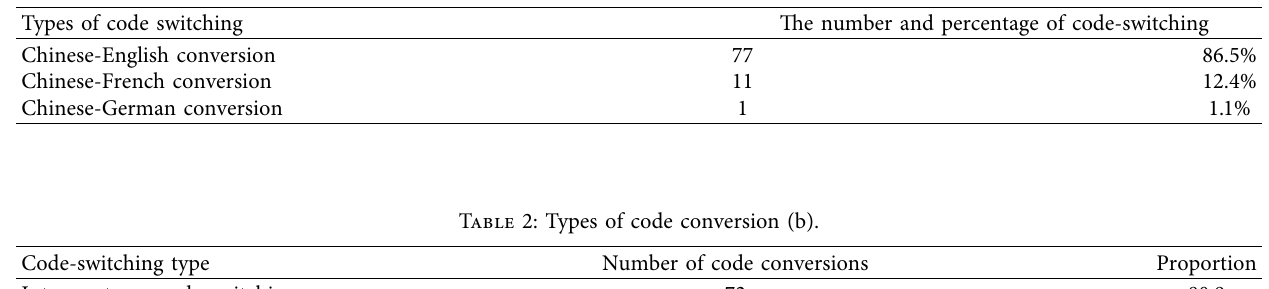
Figure 7: The distribution of code-switching in each chapter of the novel. Table 1: Types of code-switching (a).